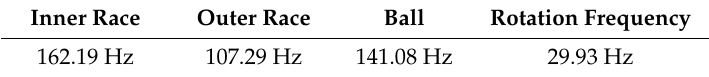
Table 2. Power spectrum results of two methods.